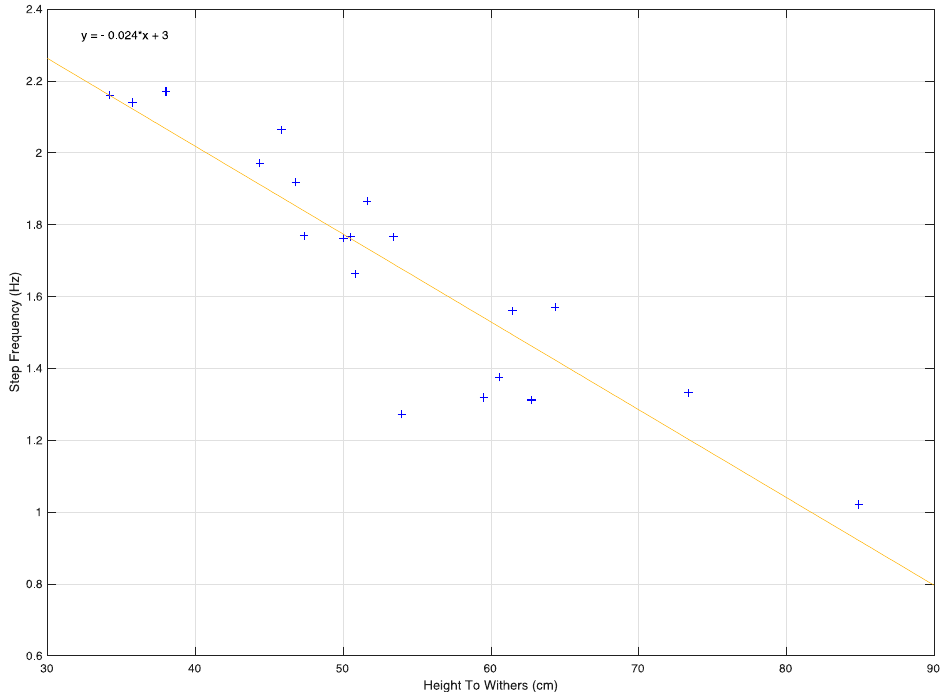
Figure 6 . Plot of height to withers vs. step frequency. The linear relationship closely resembles